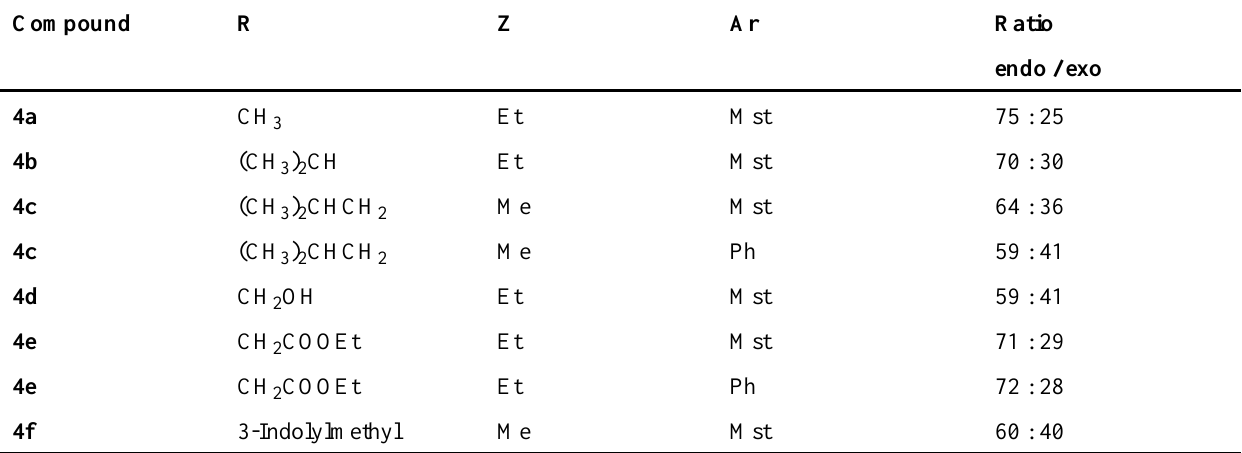
Table 2 . Stereoselectivity of 1,3-dipolar cycloaditions of nitrile oxides to maleimides 4a-f